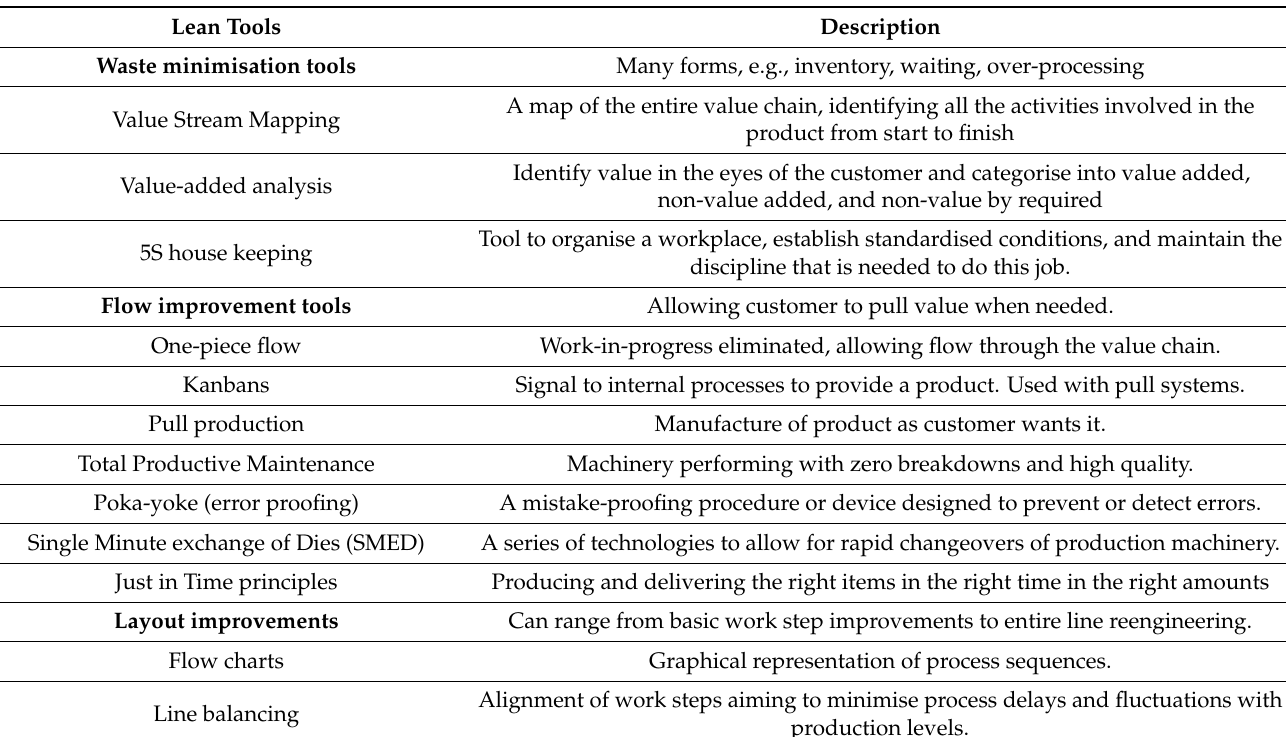
Table 1. Lean tools (author